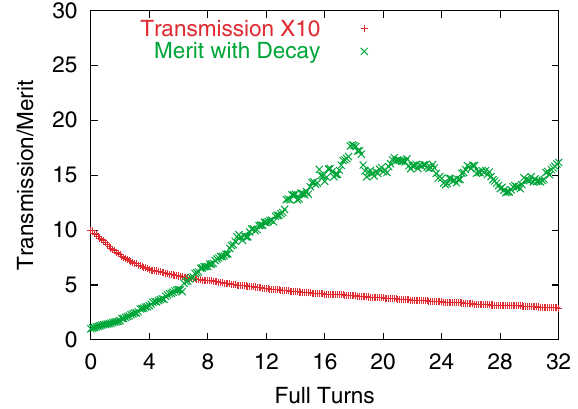
FIG. 44. (Color) The transmission and the figure of merit factor as a function of the arc length in 32 full